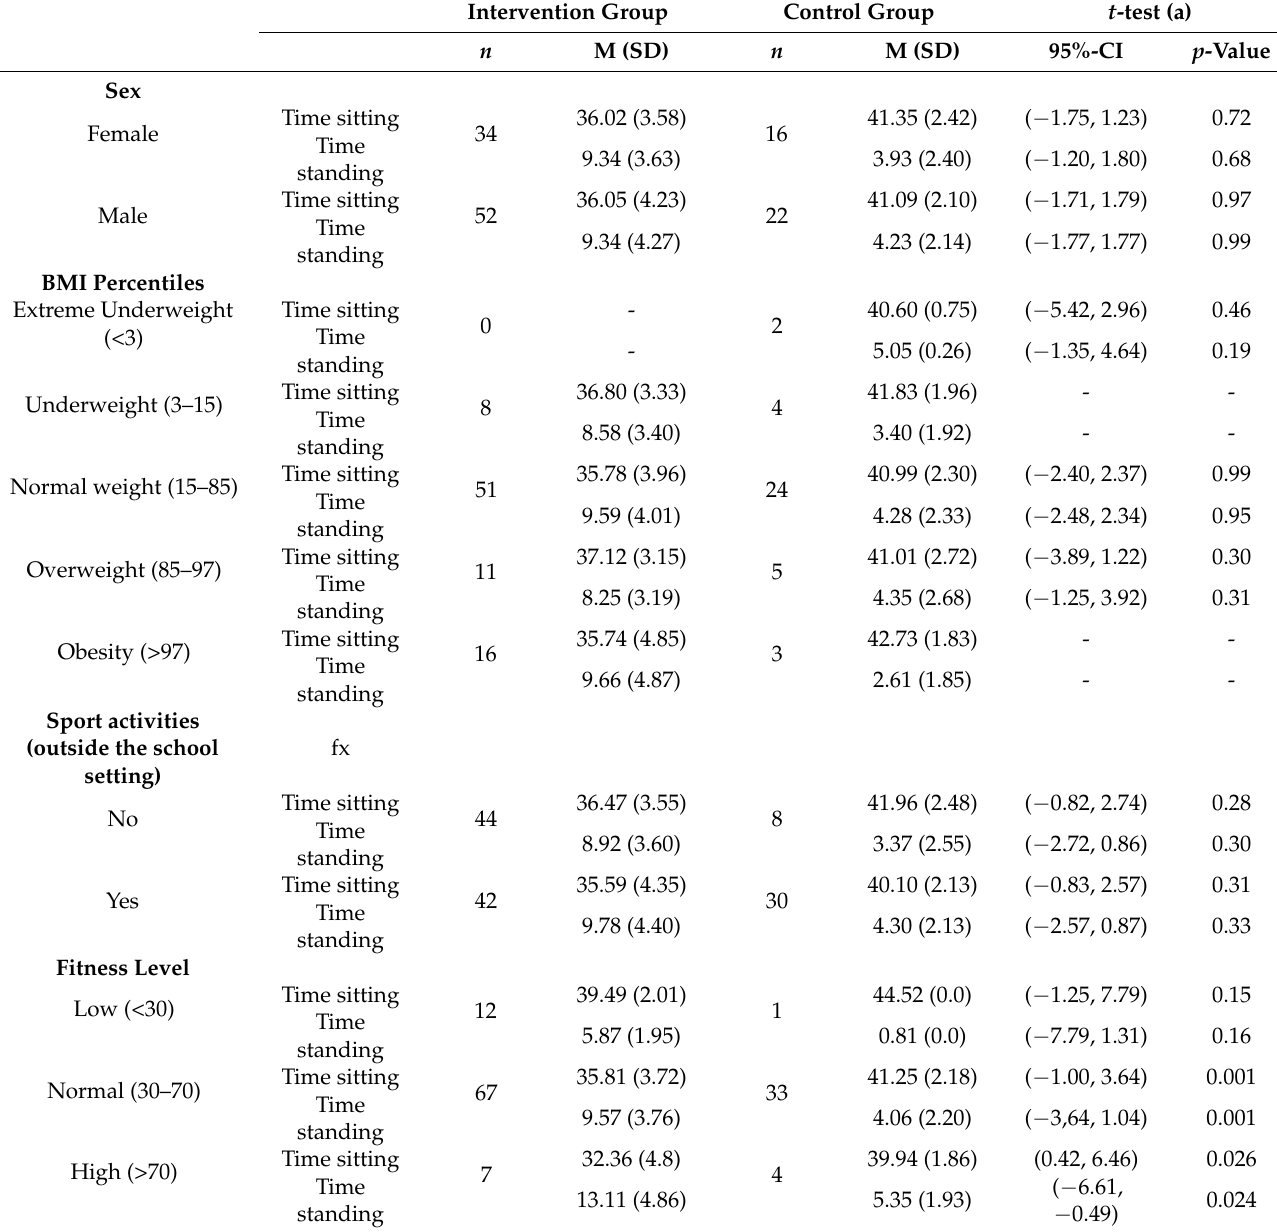
Table 4. Sitting and standing times in intervention and control groups clustered by sex, BMI per- centiles, sports and fitness